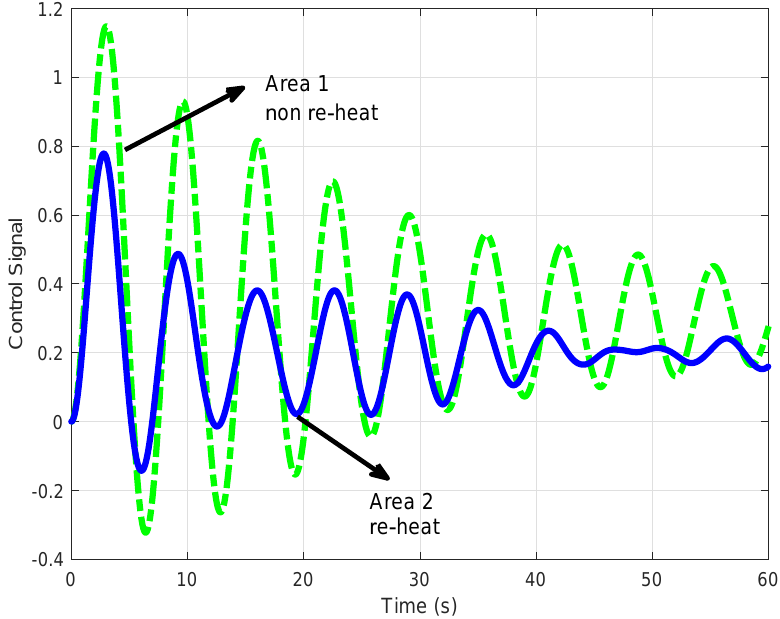
Figure 12. Control signal in areas 1 and 2 with PI controller.